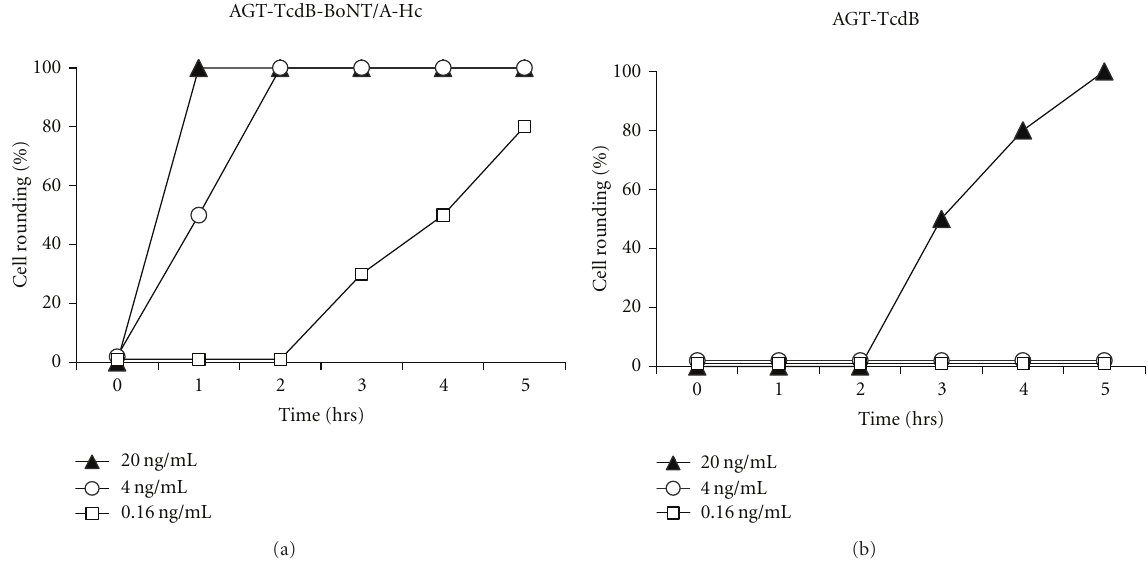
Figure 6: A TcdB chimera with the BoNT/A receptor-binding domain more rapidly elicits Neuro2A cell rounding. Neuro2A cells were exposed to three di ff erent concentrations (20ng/mL, 4ng/mL, and 0.16 ng/mL) of AGT-TcdB-BoNT/A-Hc or AGT-TcdB and the % cell rounding was assessed hourly for 5 hr. Data shown are representative of 2 independent